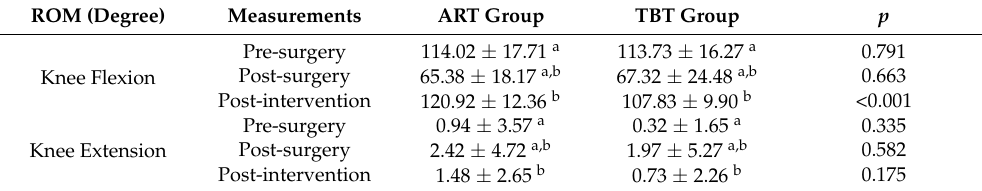
Table 2. Comparison of ROM within and between groups.